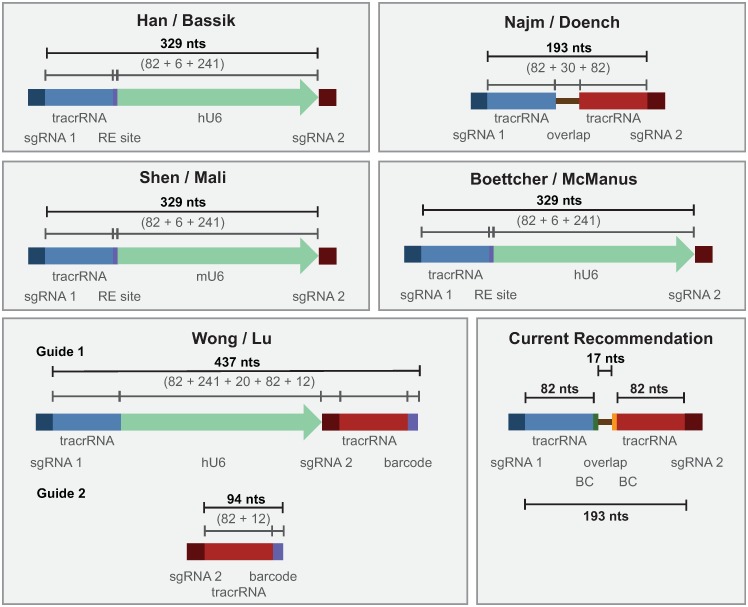
Schematics of various vector designs used for combinatorial CRISPR screens.See also Table 1. BC: barcode. RE: restriction enzyme.